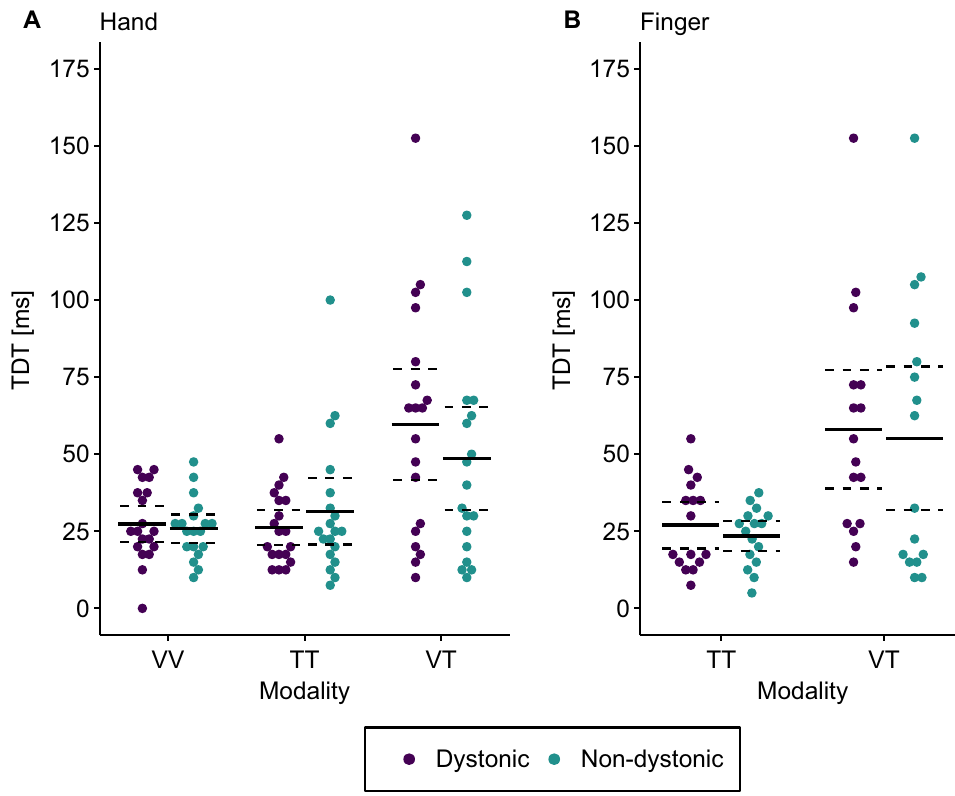
Figure 2. Temporal discrimination thresholds (TDTs) in dystonic and non-dystonic hands and fingers of patients with musician´s dystonia. ( A ) Comparison of visual (VV), tactile (TT) and visual-tactile (VT) TDTs in dystonic (purple) and non-dystonic (turquoise) hands in 19 patients with musician´s dystonia. ( B ) Comparison of tactile (TT) and visual-tactile (VT) TDTs in dystonic (purple) and non-dystonic (turquoise) fingers in 16 patients with musician’s dystonia. Solid lines represent the respective mean. Dashed lines indicate the 95% confidence interval of the